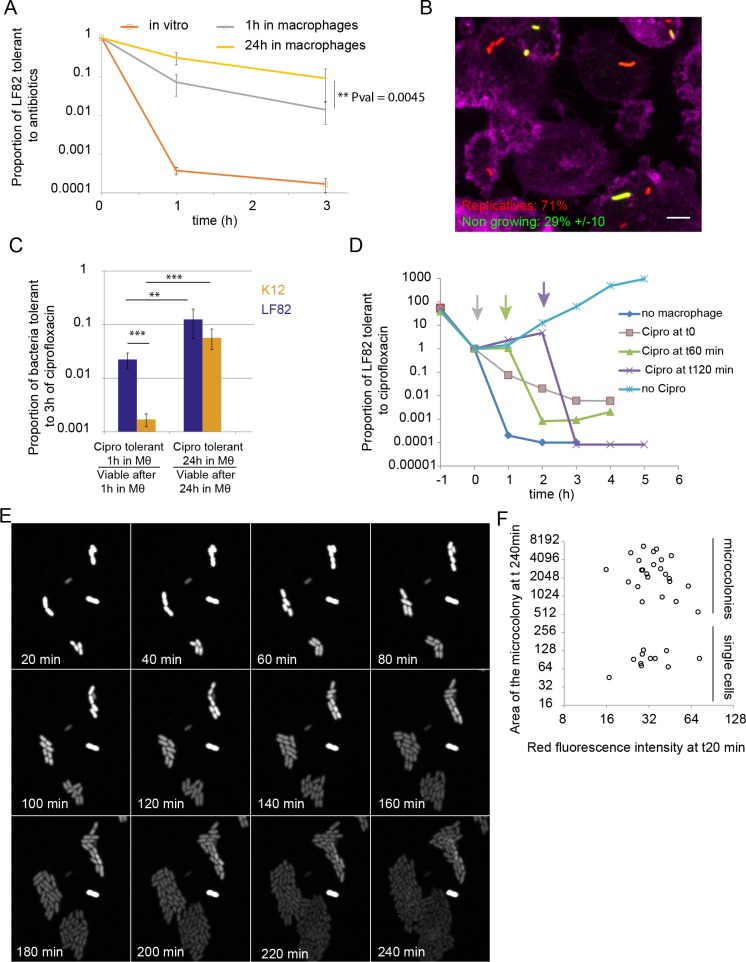
Persisters LF82 are produced during intracellular growth.A) Measure of the proportion of LF82 that were tolerant to ciprofloxacin (10x MIC) at 1 h or 3 h. LF82 were cultivated up to OD 0.3 in LB medium (in vitro) or harvested after 1 h or 24 h post infection within macrophages. The challenges exerted on bacteria having spent 1h or 24h through macrophages started immediately after macrophage lysis (see experimental procedures). Data were analyzed using a Student’s t test to determine differences with the proportion of ciprofloxacin-tolerant LF82 after a 24 h passage compared to a 1 h passage, **P < 0.01. B) Proportion of non-growing LF82 (labeled using the Fluorescent Dilution assay) observed within macrophages (24 h P.I.) following a 6 h ofloxacin (10μg/ml) treatment. C) Ratio of ciprofloxacin-tolerant versus viable LF82 and K12-C600 bacteria after macrophage infection. Values are averages of 5 experiments. Data were analyzed using a Student’s t test to determine differences with the proportion of ciprofloxacin-tolerant LF82 at 1 h post-infection, *P < 0.05 and ** P<0.001. D) Measure of the proportion of LF82 that were tolerant to ciprofloxacin at 1 h or 3 h with increasing times after macrophage lysis before ciprofloxacin addition. The data presented on this graph are representative of two independent experiments E) Imaging of the regrowth properties of individual LF82-TIMER bacteria after macrophages lysis. Infections were performed for 20 h and then macrophages were lysed, LF82 spread on to LB agarose pads and immediately imaged at 37°C. TIMER red fluorescence was progressively lost as microcolonies formed. The lysis procedure requires 20 minutes before the first field can be observed (t20 min). F) Measure of the ability of LF82 to form microcolonies as a function of red TIMER fluorescence at t20 min of the experiment are presented in E; areas of microcolonies are expressed in pixels2.